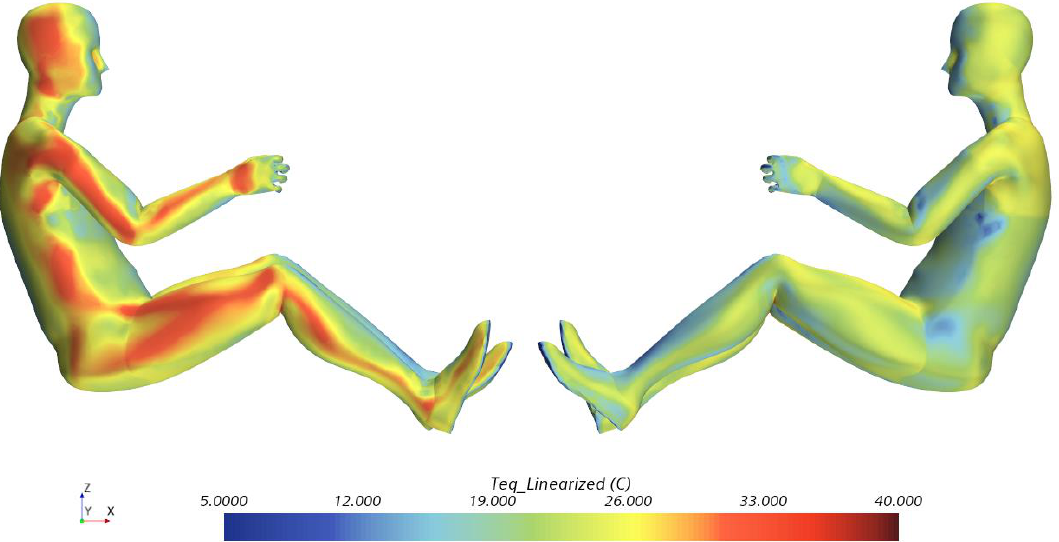
Figure 13. Linearized equivalent temperature at 25 °C inlet temperature.